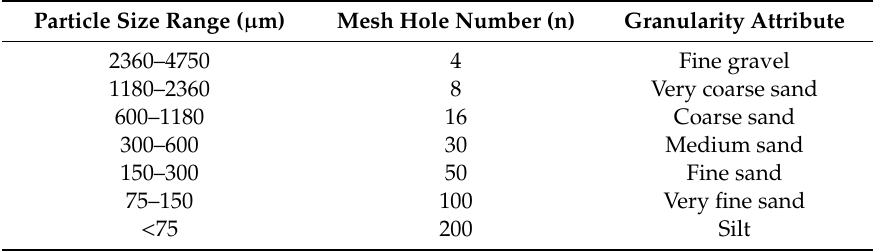
Table 7. Particle size score table of clogging